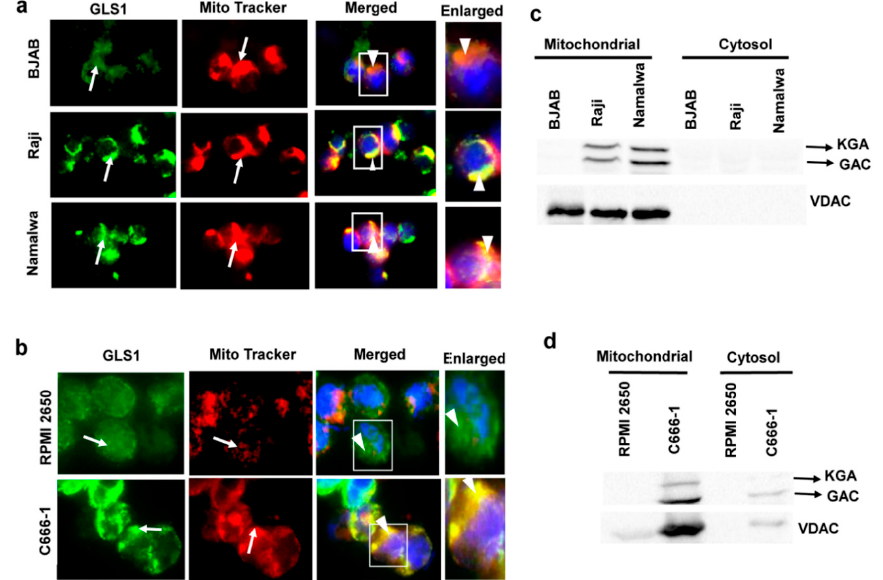
Figure 3. Mitochondrial localization of KGA and GAC in EBV-infected cells. ( a ) BJAB, Raji, and Namalwa and ( b ) RPMI 2650 and C666-1 were fixed, after an incubation of 45 min with MitroTracker (red) at 37 ° C. Cells were then washed, fixed, and stained using KGA/GAC isoform-specific antibody, followed by secondary antibody conjugated to Alexa Flour 488 (green). Nuclei were stained with DAPI (blue). Arrows indicate mitochondrial and KGA/GAC staining, and arrow heads indicate their colocalization with the mitochondrial marker. Magnification ×60. Boxed areas are enlarged on the rightmost panel. ( c ) and ( d ) GLS1 protein levels in mitochondrial fractions of EBV-infected cells. Cell lysates from BJAB, Raji, and Namalwa cell lines ( c ) and RPMI 2650 and C666-1 ( d ) cell lines were fractionated into mitochondrial and cytosolic fractions and Western blotted for GLS1 with anti-GLS1 antibody. The purity of mitochondria was confirmed by VDAC using anti-VDAC antibody.